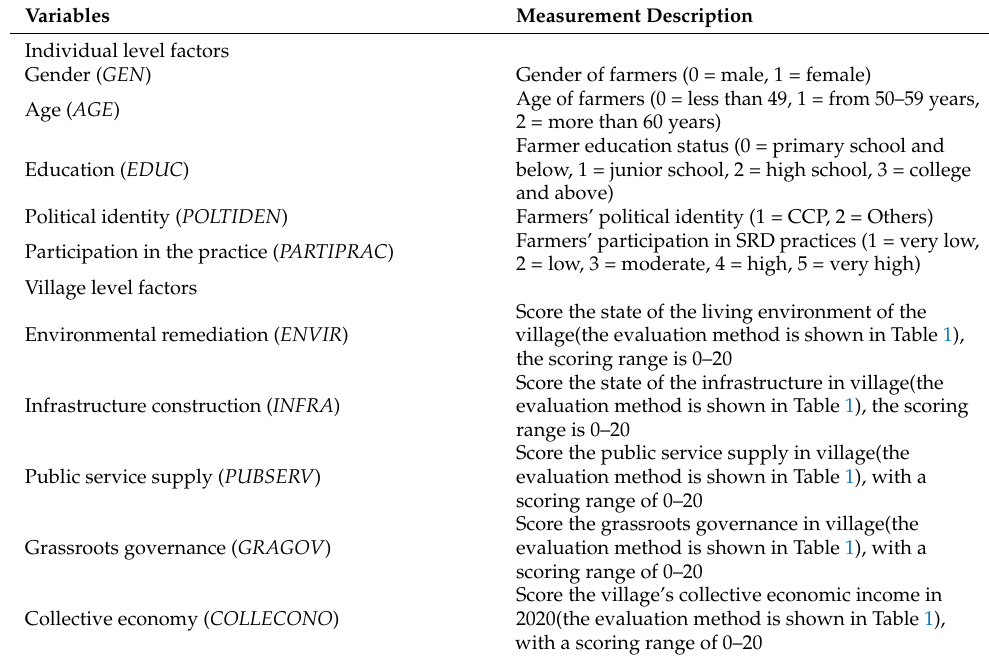
Table 2. Definition of variables in the farmers’ satisfaction